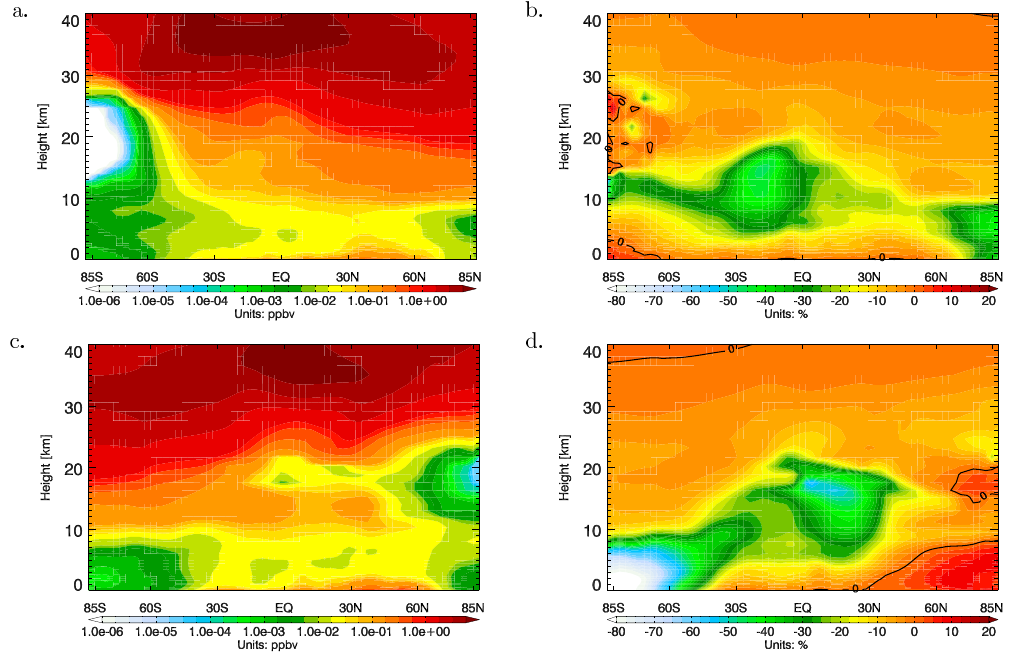
Fig. 1. The zonal mean NO 2 mixing ratio in REF 2000, for July (a) and December (c) . Panels (b) and (d) show the percent change in mixing ratio from REF 2000 to R2 2000, for July and December,